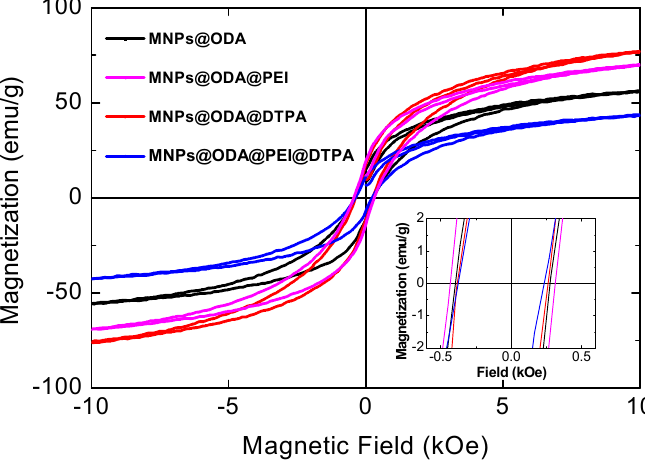
Figure 4. Room-temperature hysteresis loops recorded by vibrating sample magnetometry (VSM).